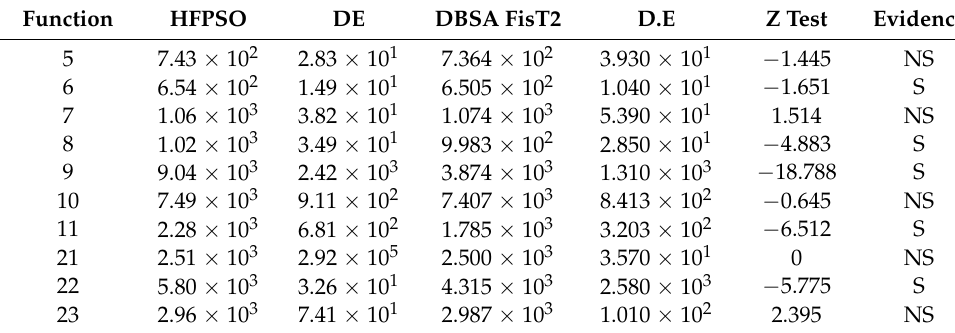
Table 15. Statistical test results for CEC2017 functions using IT2FS.